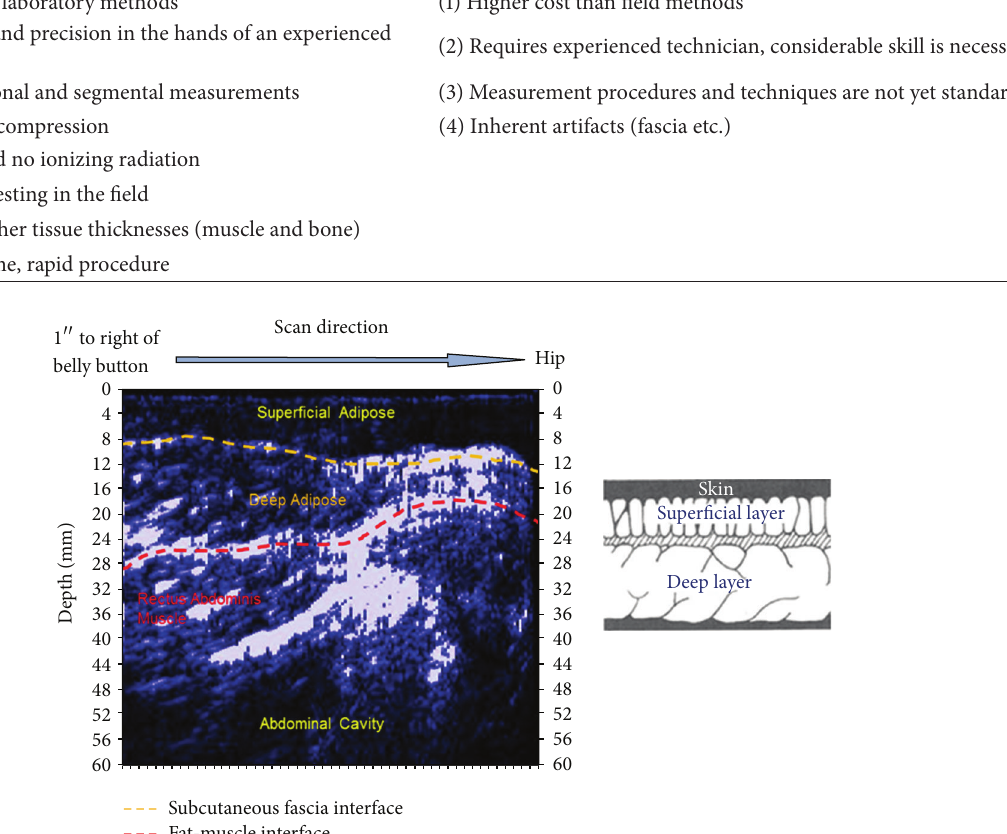
Figure 3: Image and illustration of an ultrasound scan showing superficial adipose tissue and deep adipose tissue (provided with permission from IntelaMetrix, Inc., Livermore,